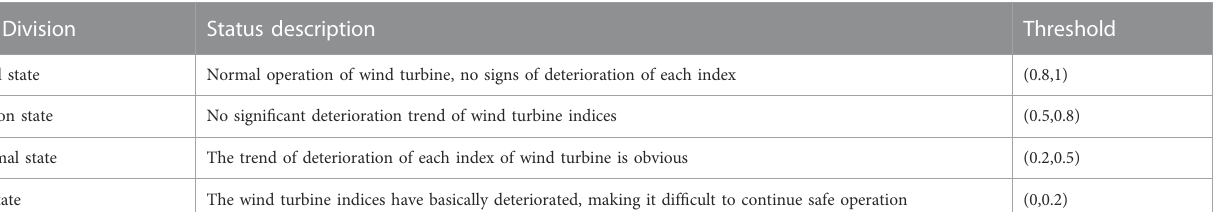
TABLE 1 Wind turbine state levels and the normalized index interval thresholds.